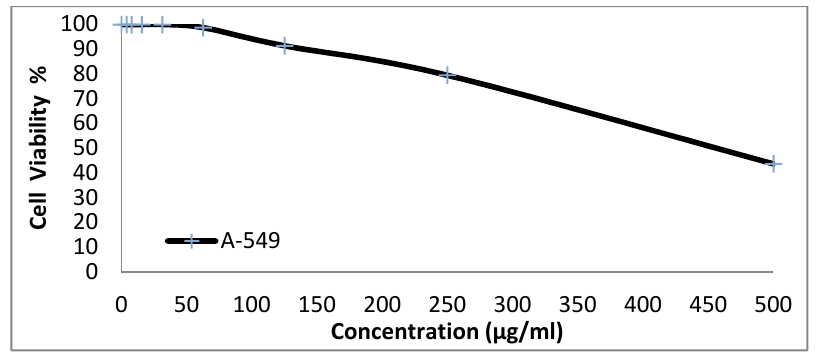
Figure 10. Evaluation of disperse dye 14y on cell line A-549.